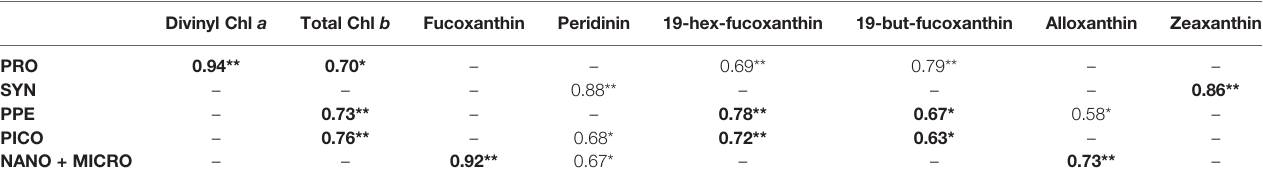
TABLE 4 | Correlation matrix for comparisons of measured group-speci fi c Chl a for Prochlorococcus (PRO), Synechococcus (SYN), picophytoeukaryotes (PPE) and HPLC